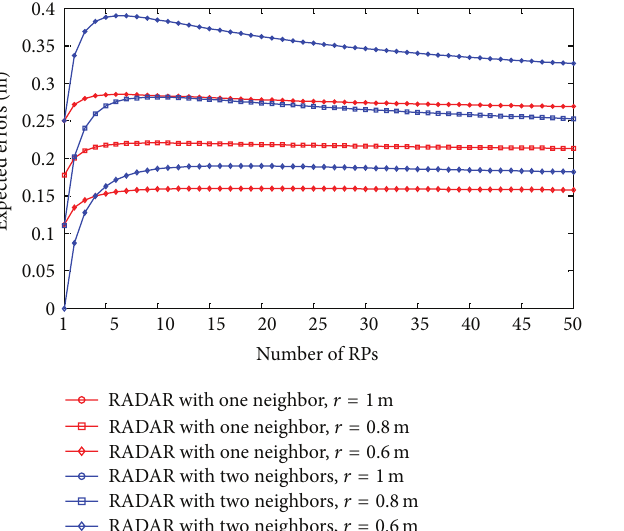
Figure 6: Error comparison by one- and two-neighbor matching localization.